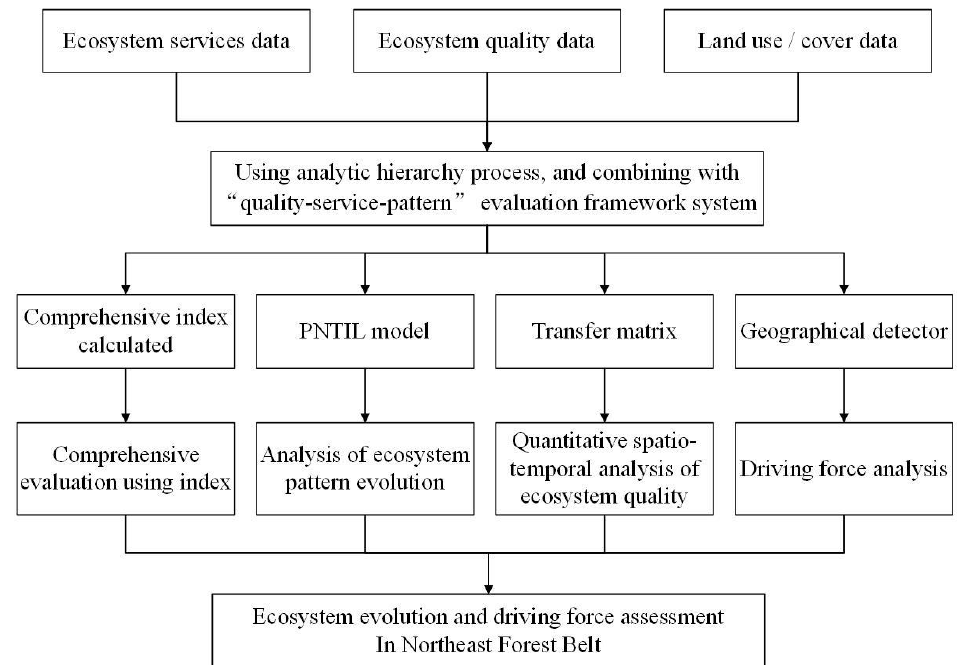
Figure 2. Technology roadmap.